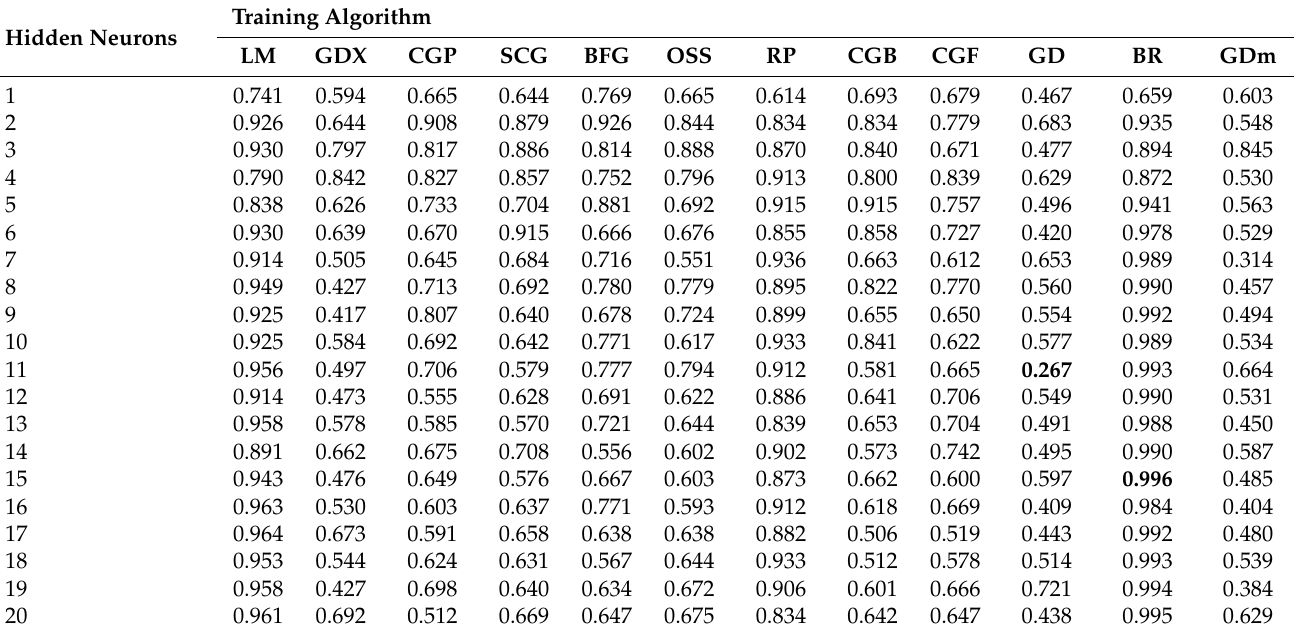
Table A15. R value for methane yield in biogas for different training algorithms at different number of hidden neurons.